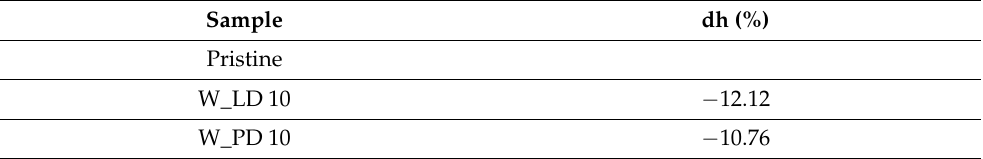
Table 3. Change in fabric thickness after 10 washing cycles in liquid and powder detergents.